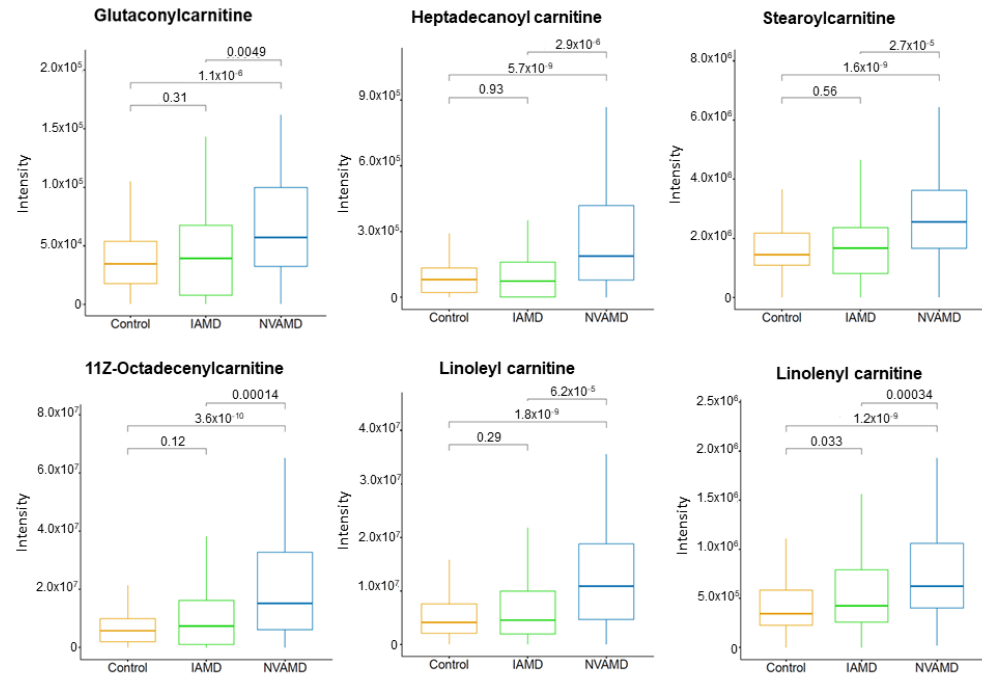
Figure 2. Medium- and long-chain plasma acylcarnitines altered in AMD patients. Plasma levels of six acylcarnitines that were higher in NVAMD patients compared to either IAMD patients or controls. Kruskal–Wallis tests were used for pairwise comparisons and p -values are shown above comparison brackets. The molecular identities of these acylcarnitines have been confirmed at MSI level